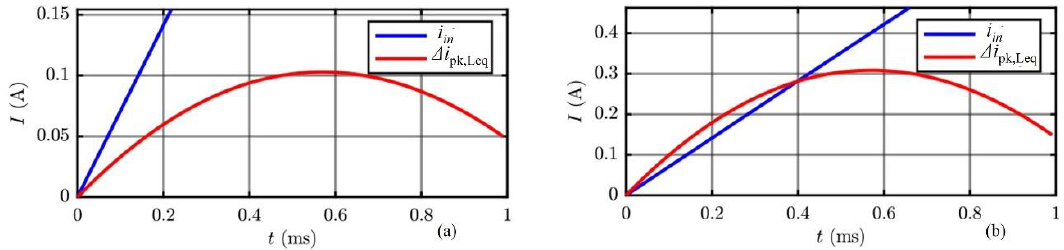
Figure 8. ( a ) Peak current ripple and input current comparison for L eq = 900 μH, ( b ) Peak current ripple and input current comparison for L eq = 300 μH.